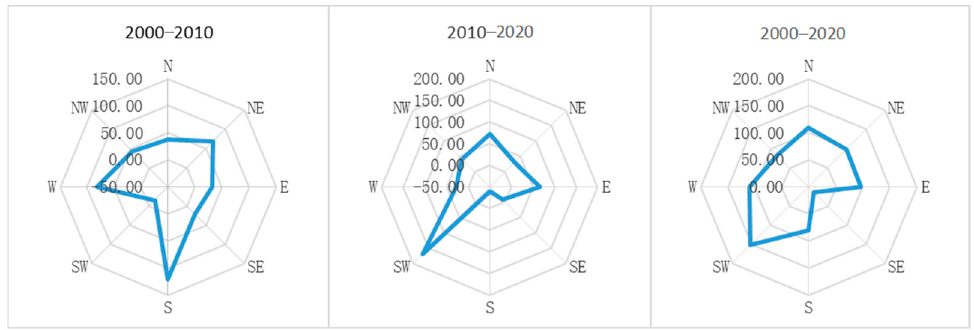
Figure 8. Area distribution of Wuhan urban fringe areas along different directions of expansion,